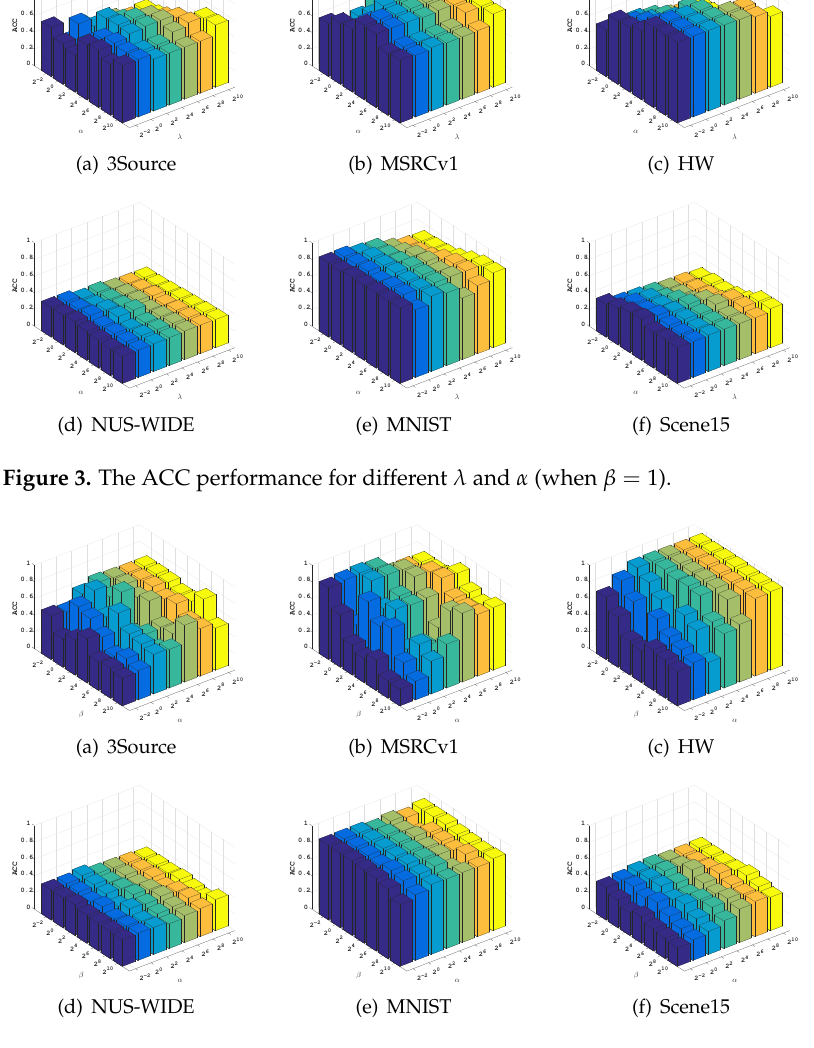
Figure 4. The ACC performance for different α and β (when λ = 1).